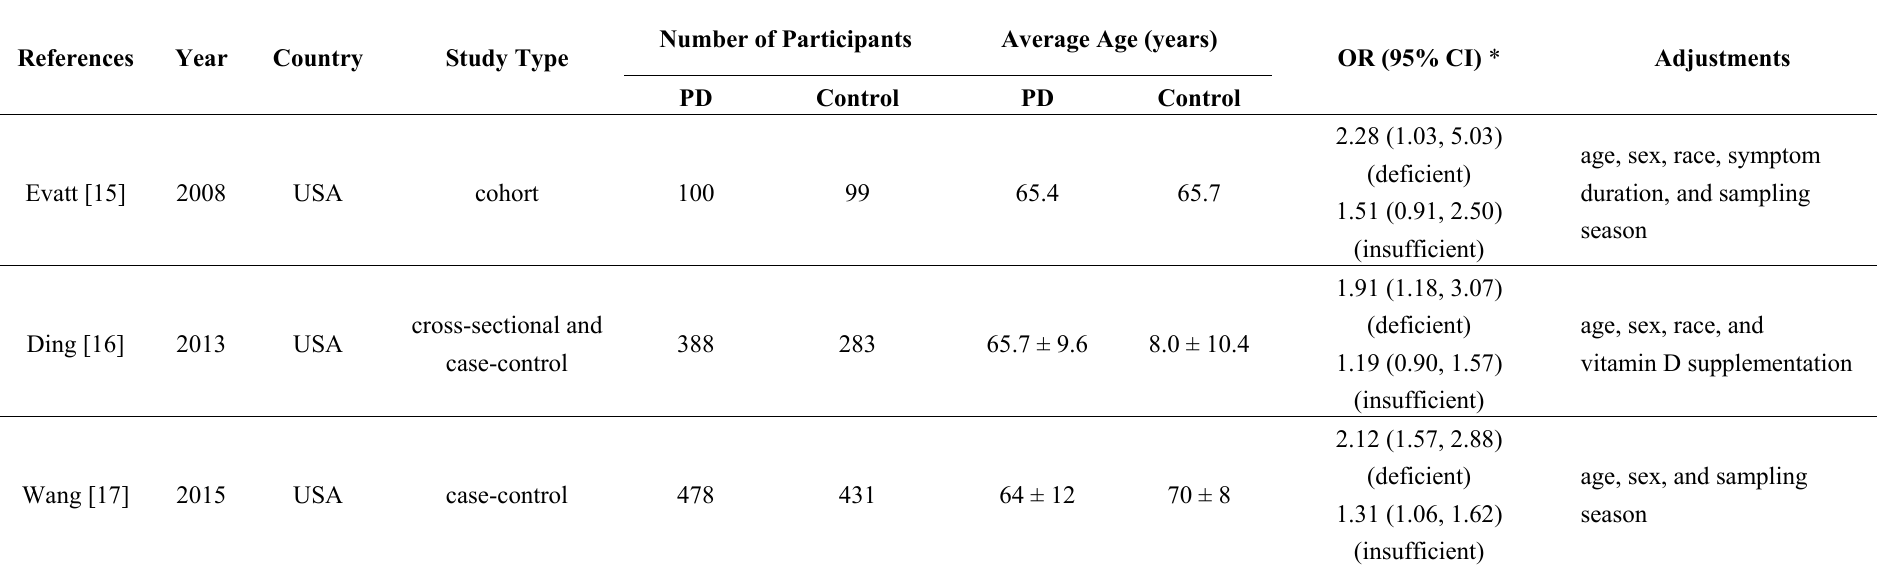
Table 1. Main characteristics of eligible studies for the analysis of vitamin D deficiency and risk of